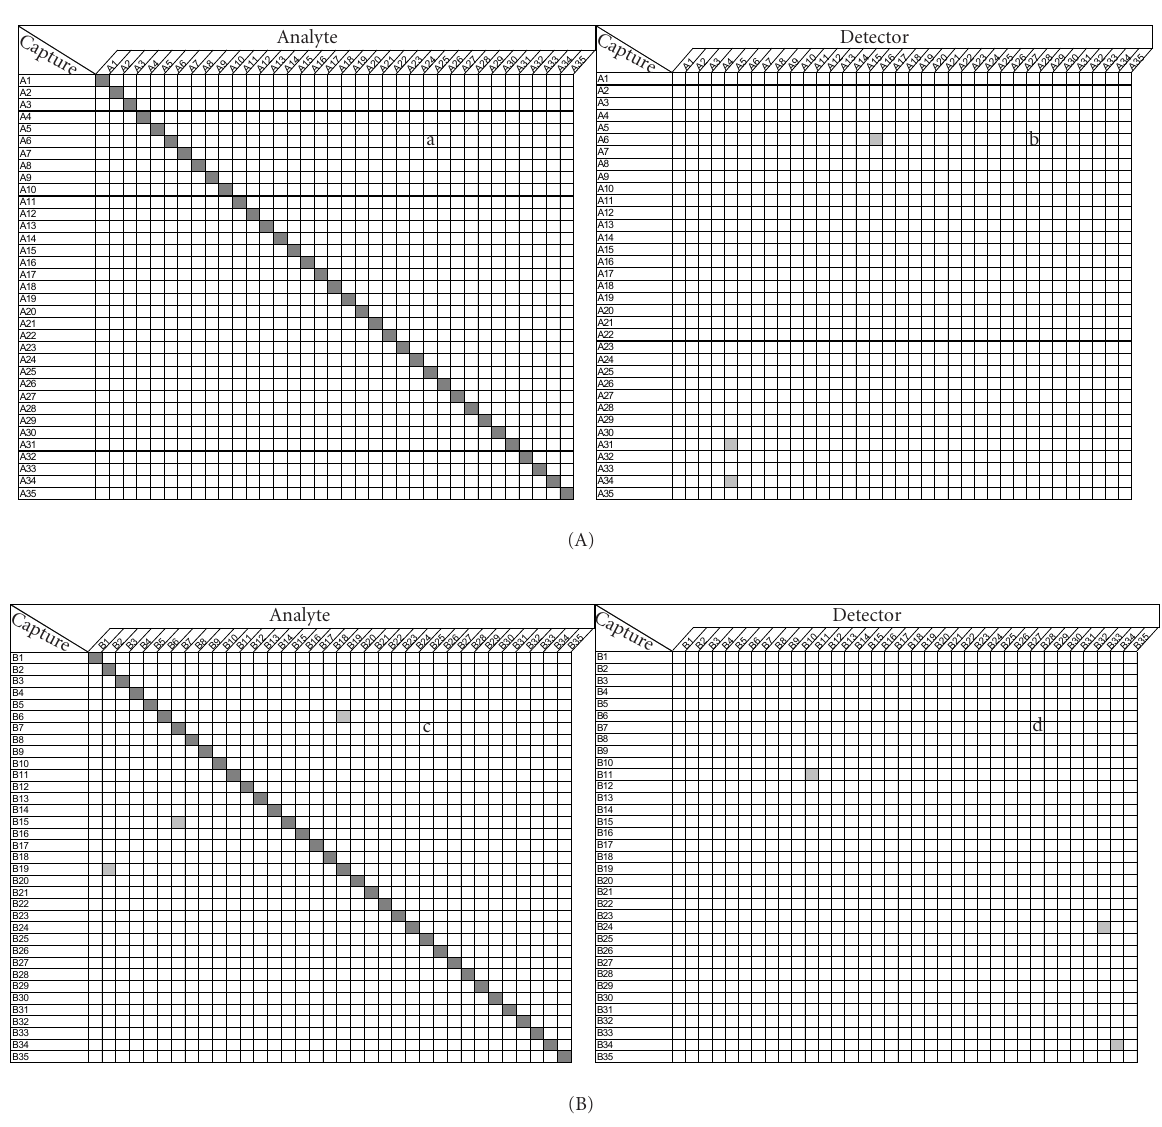
Figure 4. Cross-reactivity of capture antibodies and analytes ((a) and (c)), capture antibodies and detection antibodies ((b) and (d)) on the subarrays 3 (A) and 4 (B). Each subarray was printed with about 35 di ff erent capture antibodies (listed on the chart). Cross- reactivity was determined by using di ff erent matched secondary antibody and 50 ng/mL or 0ng/mL of its cognate analyte, which has been described in the text. A shaded square o ff the diagonal indicates the presence of nonspecific signals (intensity ≥ 300). None of these nonspecific signals exceed the intensity of 600 fluorescence intensity units (images are scanned at PMT of 600 and power of 100% on Axon